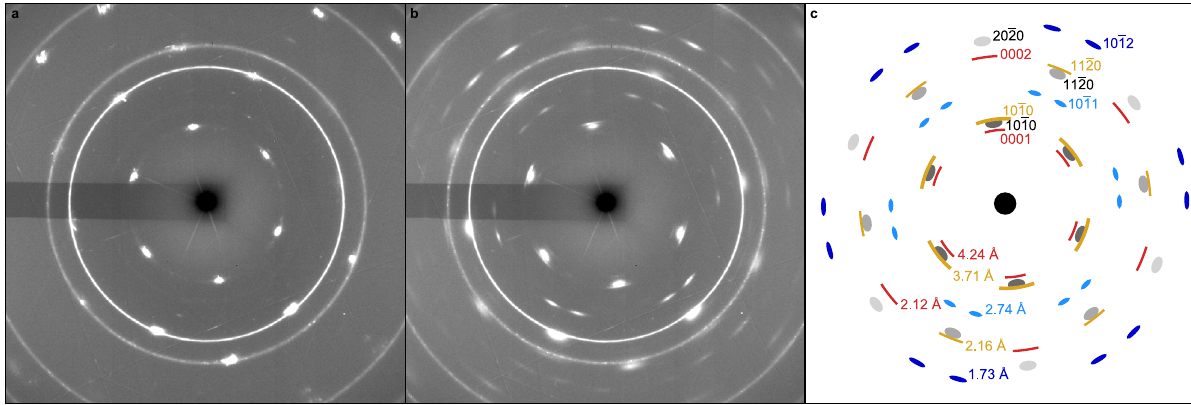
Fig.1| X-raydiffractionpatternsofquartzsinglecrystalcompressedalongthe [0001] direction. The single-crystaldiffraction patterns ( a ) and ( b ) werecollected during compression at 10 and 25GPa. Circular Debye rings correspond to the polycrystallinegoldstandardusedasapressurecalibrant.( c )representsasketchof